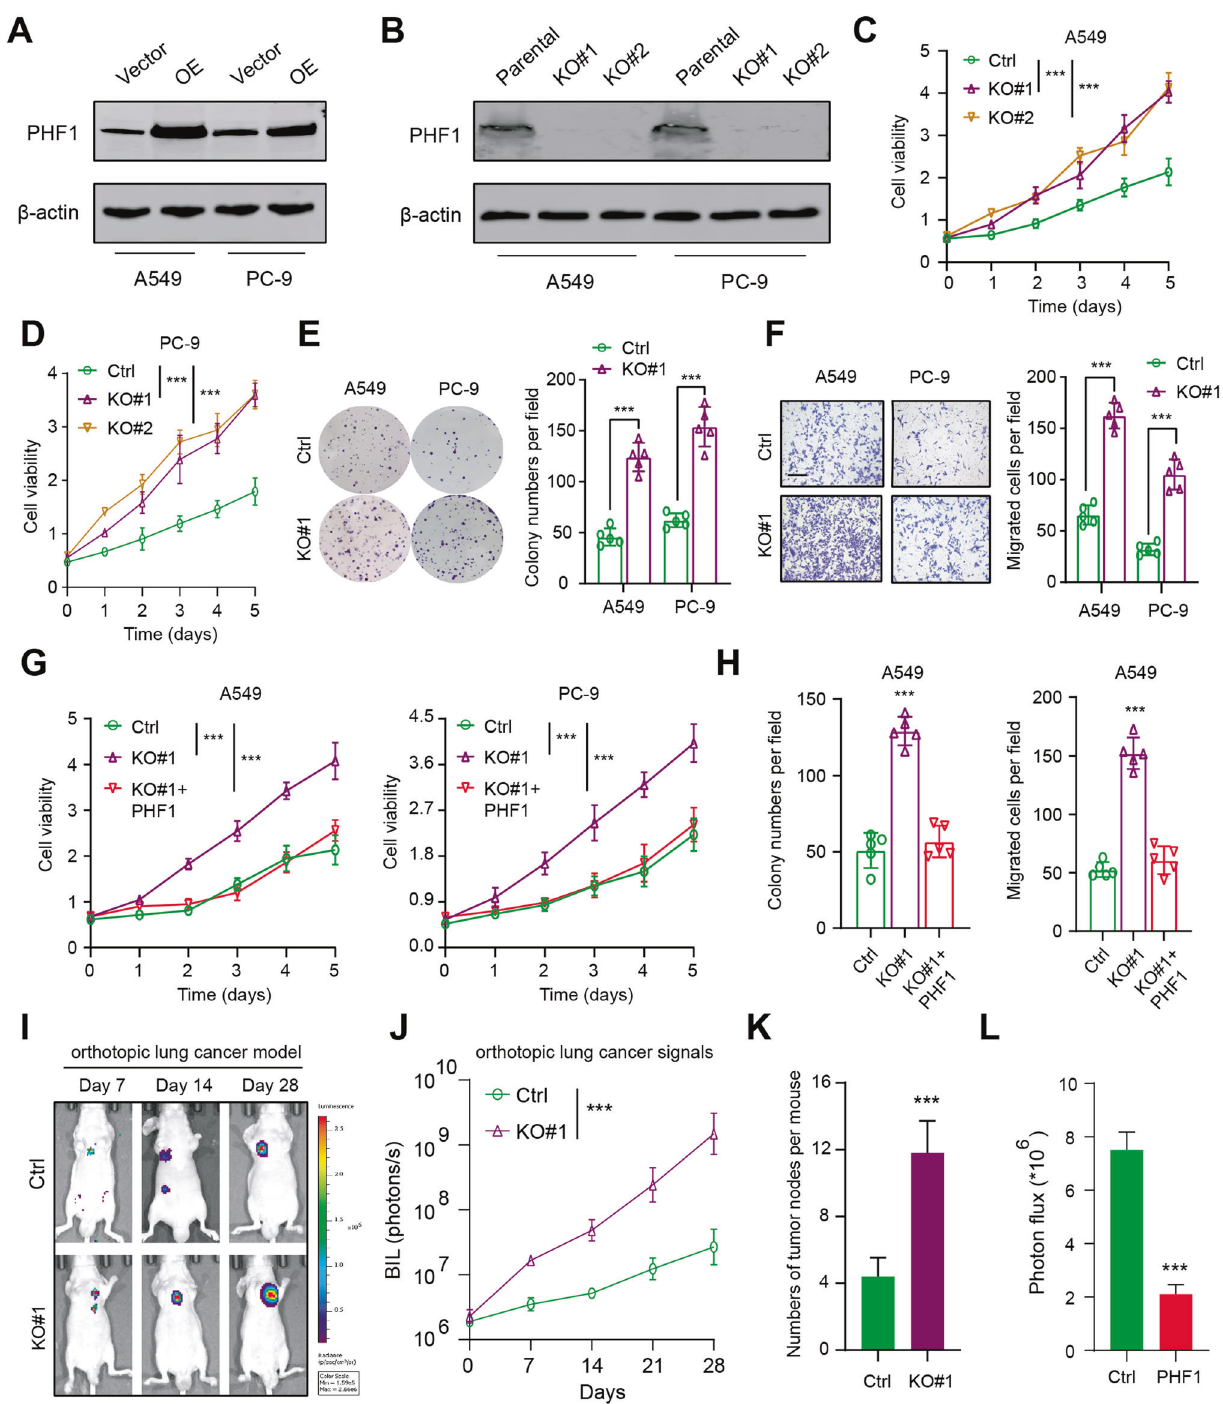
Fig. 2 Experimental assays demonstrated that PHF1 functions as a biological tumor supperessor in LUAD. A Western blotting showing the ectopic expression of PHF1 in A549 and PC-9 cells. B Western blotting showing the CRISPR/Cas9 -mediated KO of PHF1 in LUAD cells. C MTT assay was conducted to assess the effect of PHF1 de fi ciency on A549 cell viability. D MTT assay was conducted to assess the effect of PHF1 de fi ciency on PC-9 cell viability. E Colony formation assay revealing the effect of PHF1-KO on cell clone growth capacity (A549 and PC-9). F Cell migration assays showing the effect of PHF1-KO on migratory abilities of LUAD cells (A549, PC-9). G PHF1 de fi ciency notably enhanced the proliferation of A549 and PC-9 cells, wheras ectopic expression of PHF1 restored the in vitro growth of cells. H Colony formation assay and migration assay were performd in three cell groups (Ctrl, KO#1, KO#1 + PHF1) to determine whether PHF1 overexpression could restore the malignant features of cells. I Representative bioluminescence (BIL) imaging graphs showing the in vivo orthotopic tumor growth in two groups. J Quanti fi cation of orthotopic lung tumor signals in two groups which were detected at the indicated timepoints. K Quanti fi cation of orthotopic tumor leision numbers via dissecting the mice lung in the indicated groups. L Quanti fi cation of BIL signals in the Ctrl and PH1-OE groups at the Day 28. Bar = Mean ± SD. * P < 0.05, ** P < 0.01, *** P <